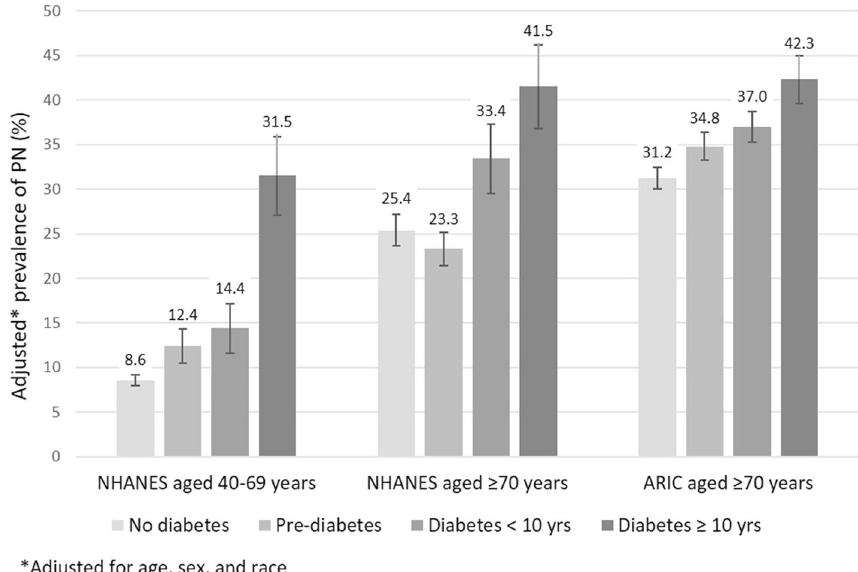
Figure 1. Age, sex, and race-adjusted prevalence of peripheral neuropathy stratified by diabetes status in US adults aged 40–69 and ≥ 70 years (NHANES, 1999–2004) and ARIC participants aged ≥ 70 years (Visit 6,